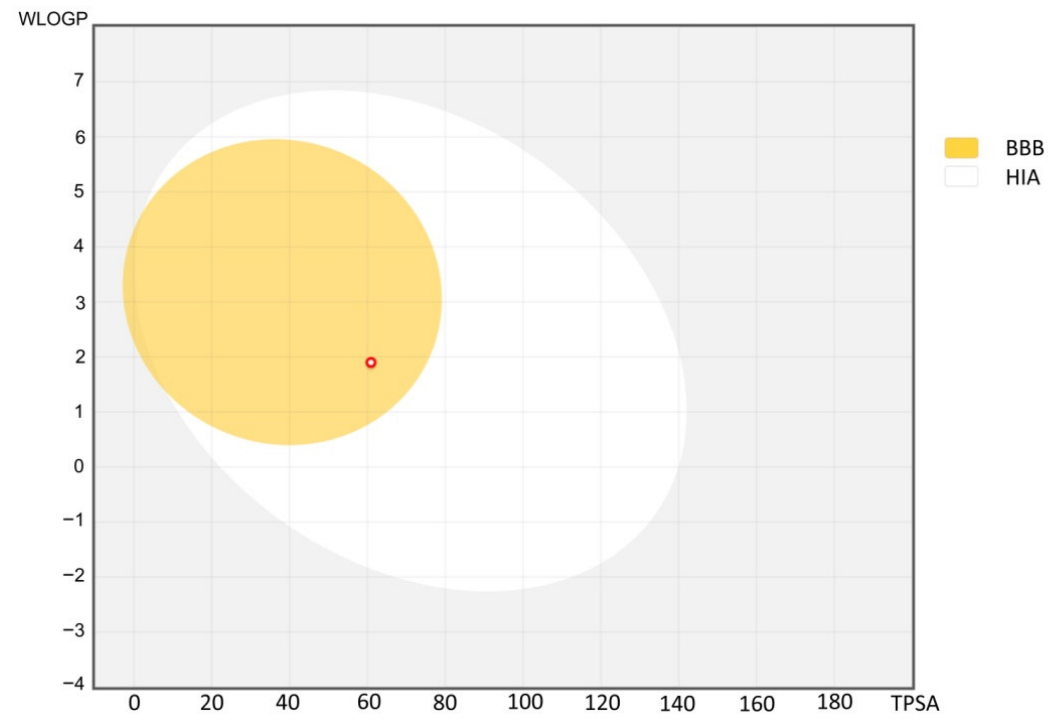
Figure 6. The BOILED-Egg predictive model for C-11 (visible as dot marked in red). The white region (HIA) is the physicochemical space of molecules with the highest probability of being absorbed from the gastrointestinal tract, and the yellow region (BBB) is the physicochemical space of molecules with the highest probability to permeate to the brain.